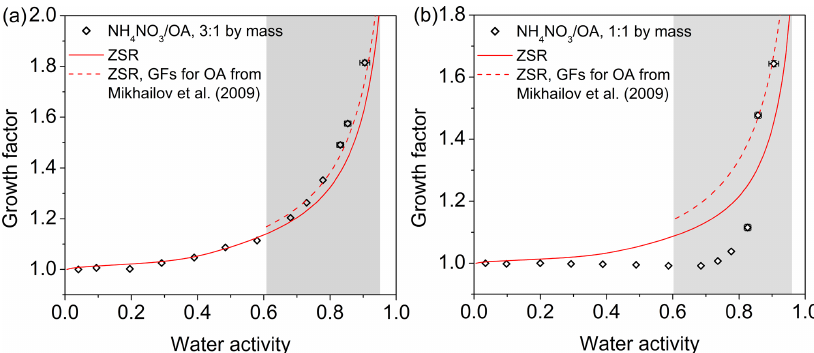
Figure 2. Hygroscopic growth factors of 100nm NH 4 NO 3 / oxalic acid (OA) mixed particles with mass ratios of (a) 3:1 and (b) 1:1 as a function of water activity. The ZSR-predicted curves based on GF = 1 for oxalic acid or GFs from Mikhailov et al. (2009) are indicated by red solid and dashed lines, respectively. The error bars representing the standard deviation of multiple measurements are generally not obvious compared to the size of the symbols. The shaded area shows potential water uptake by the oxalic acid component under high RH